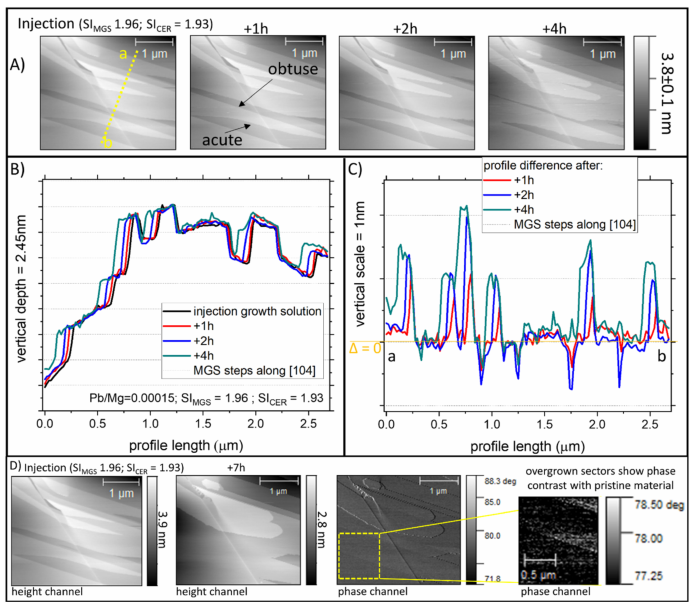
Figure 6. ( A ) Sequence of images from the height channel. The images cover a time range of 4 h after the injection of a supersaturated solution containing Pb 2+ on {10.4} MGS surfaces. ( B ) Section profiles are extracted from successive frames to calculate the step advancement rate. The profiles are compared by introducing a constant offset to align the height and the position of the maximum in every profile. ( C ) The difference between the initial and the actual profile allows us to visualize and to quantify the overgrown regions of the step edges. ( D ) The overgrown regions of the steps show a phase contrast with the pristine regions; this effect is likely due a change in electron density caused by Pb 2+ incorporation.